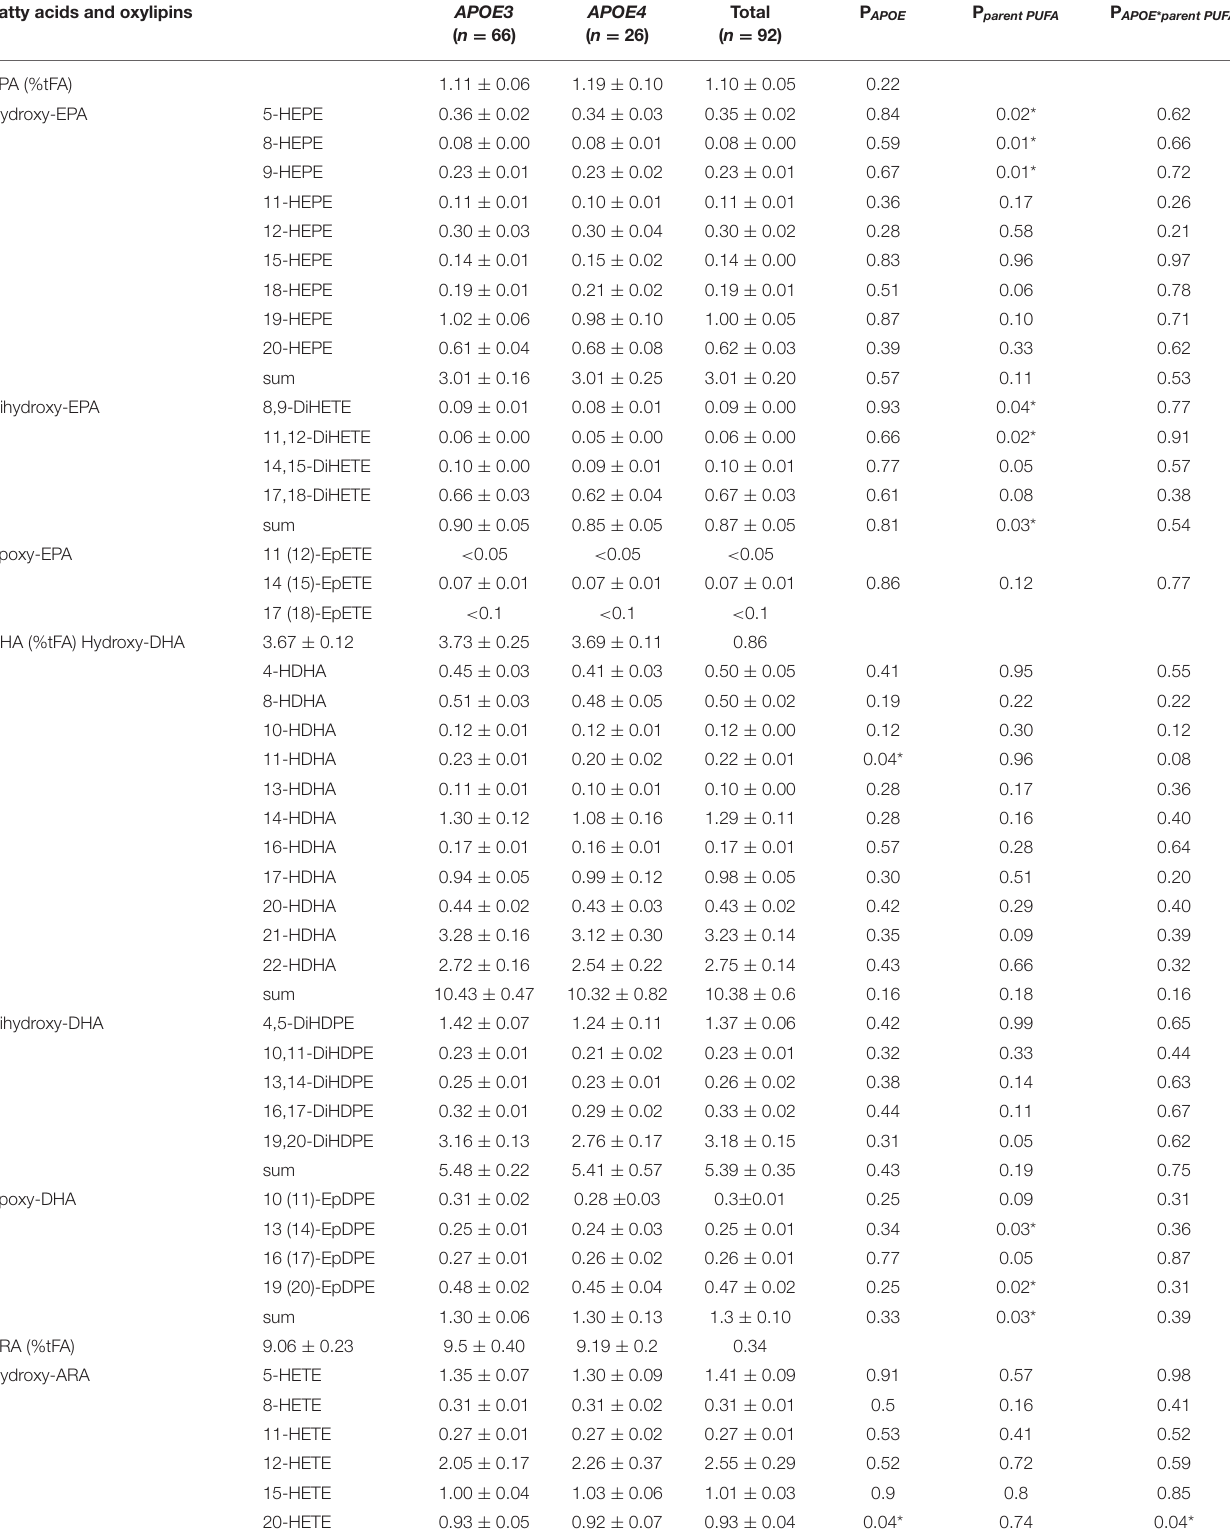
TABLE 3 | Baseline plasma phosphatidylcholine fatty acids (% of total fatty acids; %tFA) and oxylipin concentrations (nM) in APOE3 and APOE4 individuals. Fatty acids and